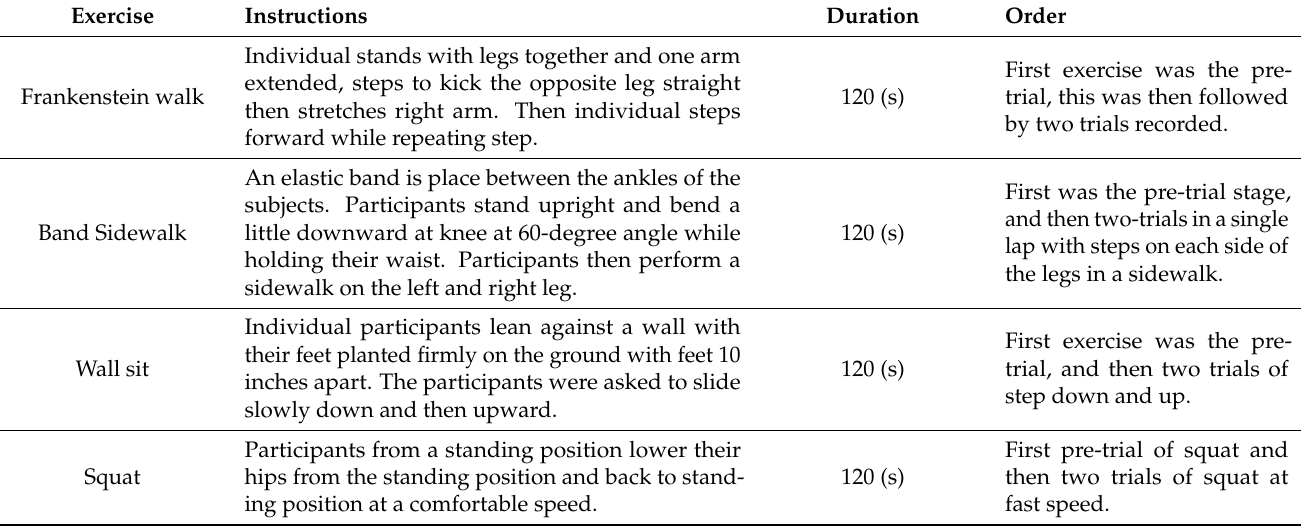
Table 1. Methodology for the